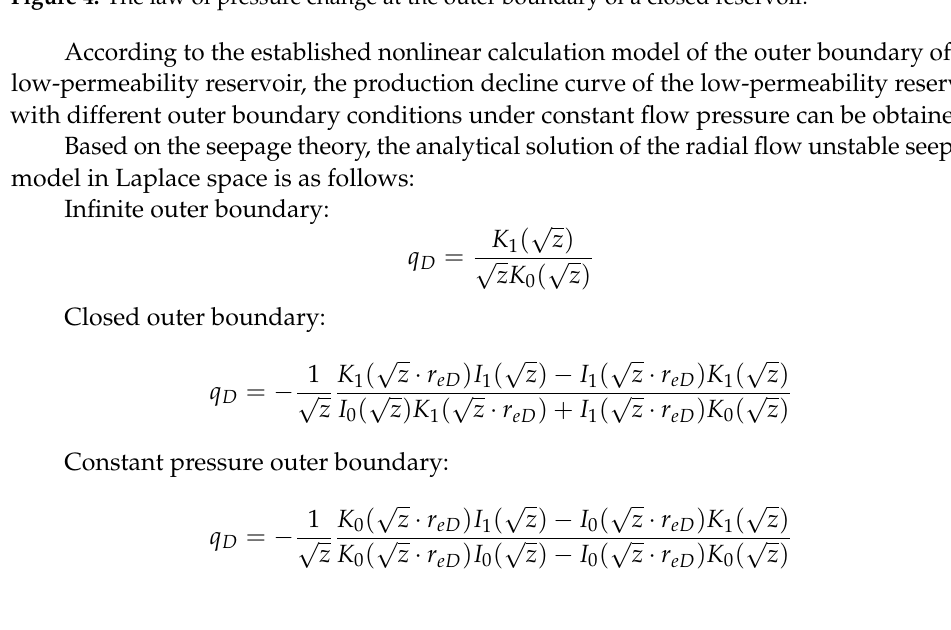
Figure 4. The law of pressure change at the outer boundary of a closed